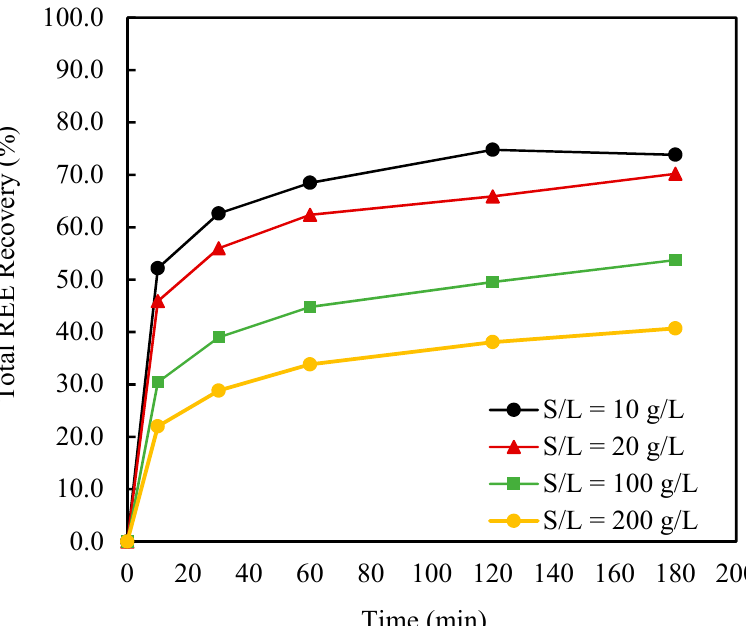
Figure 7. Effect of solid-to-liquid ratio on the leaching recovery of total rare earth elements contained in the Fire Clay coal middlings (75 ◦ C, 1 M H 2 SO 4 , 530 rpm, D 80 = 8.7 µ m).